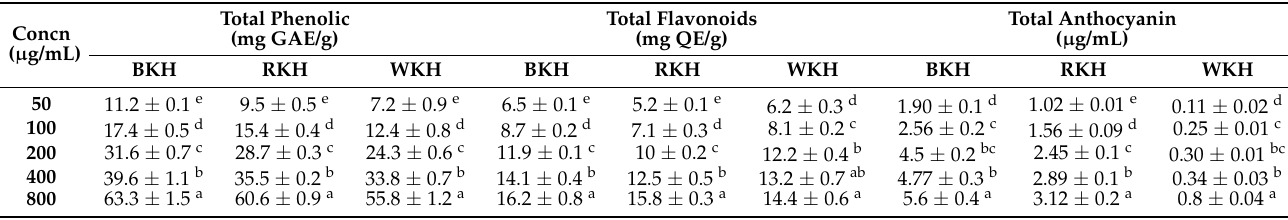
Table 3. Total phenolic, total flavonoids and total anthocyanin content in different concentrations of black, red and white kidney bean protein hydrolysates (BKH, RKH, and WKH) obtained after 30 min Alcalase hydrolysis at 37 ◦ C. Concn ( µ